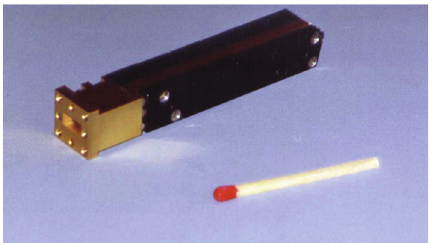
Figure 3: Single radiometric sensor.